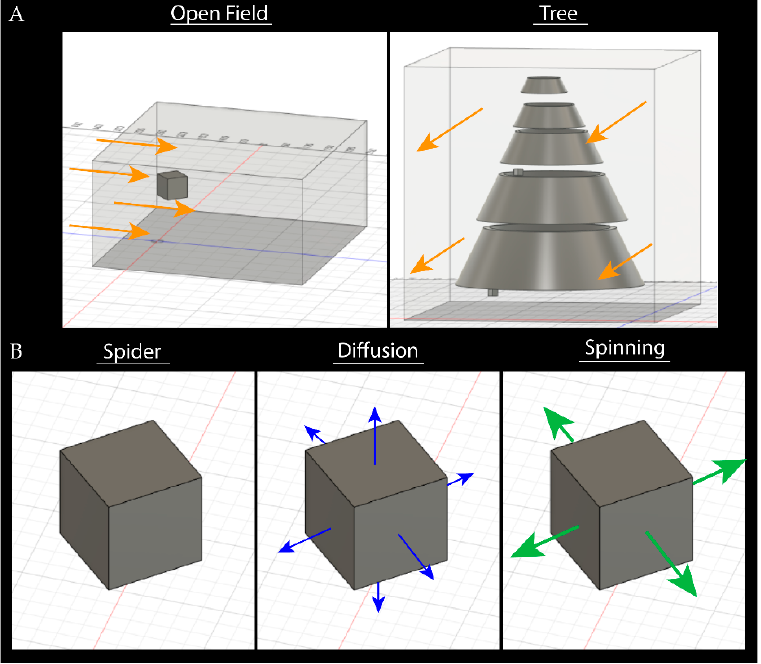
Figure 2. Environment models and flow conditions used in computational fluid dynamics modeling. ( A ) Open field tests involved a rectangular environment open on all sides except the bottom. Orange arrows show the direction of the wind, behind the spider, at 3 m/s. The tree model was made of five rings, and two spiders were placed due to being a larger structure, one at the top and one at boom. ( B ) The spider and pheromone cloud were modeled as a perfect cube, with sides of length 1 cm. The diffusion condition applied a small velocity, 0.05 m/s, exiting all faces of the cube. The spinning condition applied a larger velocity, 3 m/s, exiting the four front and back faces of the spider. In each model, the spider was represented as a cube-shaped volume of pheromones, using the default material properties of ‘Air’ material (Figure 2B). The field model consisted of a large open rectangular area with only boundary conditions on the floor. Within the field, results were shown as the airflow velocity along three planes parallel to the wind: one in the plane of the spider, one slight above, and one slightly below. Our tree model is composed of four increasingly smaller plates, forming a cone shape, to mimic the open space of the leaves where the spider hangs. For the tree conditions, two spiders were placed within the confines of the tree with one at the bottom and one at the top (Figure 2A). The flow is shown by four planes (1) bisecting the tree, parallel to the tree trunk, (2) perpendicular to the wind flow, just before the wind contacts the tree, (3) a plane parallel to the flow of wind and located directly below the opening of the canopy, and (4) a plane parallel to the wind bisecting the tree halfway